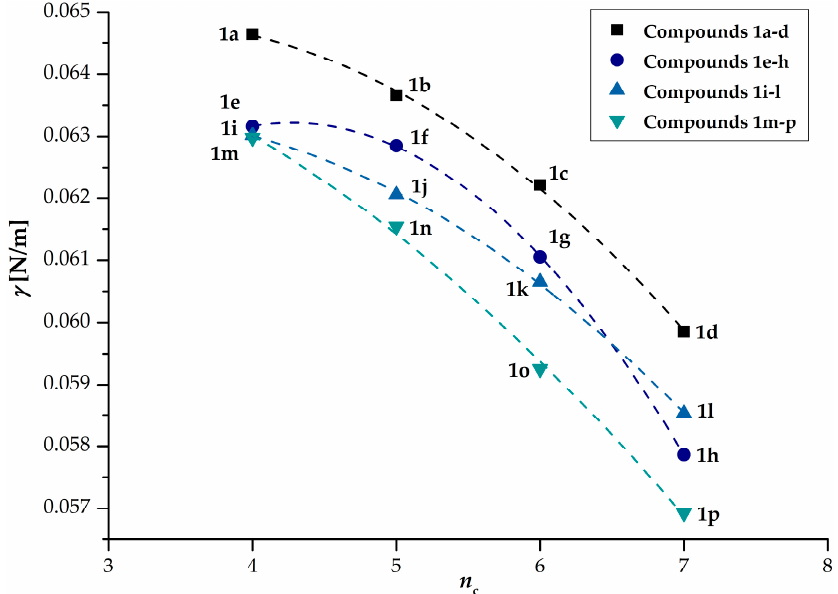
Figure 2. Relationships between number of carbon atoms forming the 2-/3-alkoxy side chain R ( n c ; alkoxy = butoxy to heptyloxy) and γ values (in N/m units) of the compounds 1a – p .